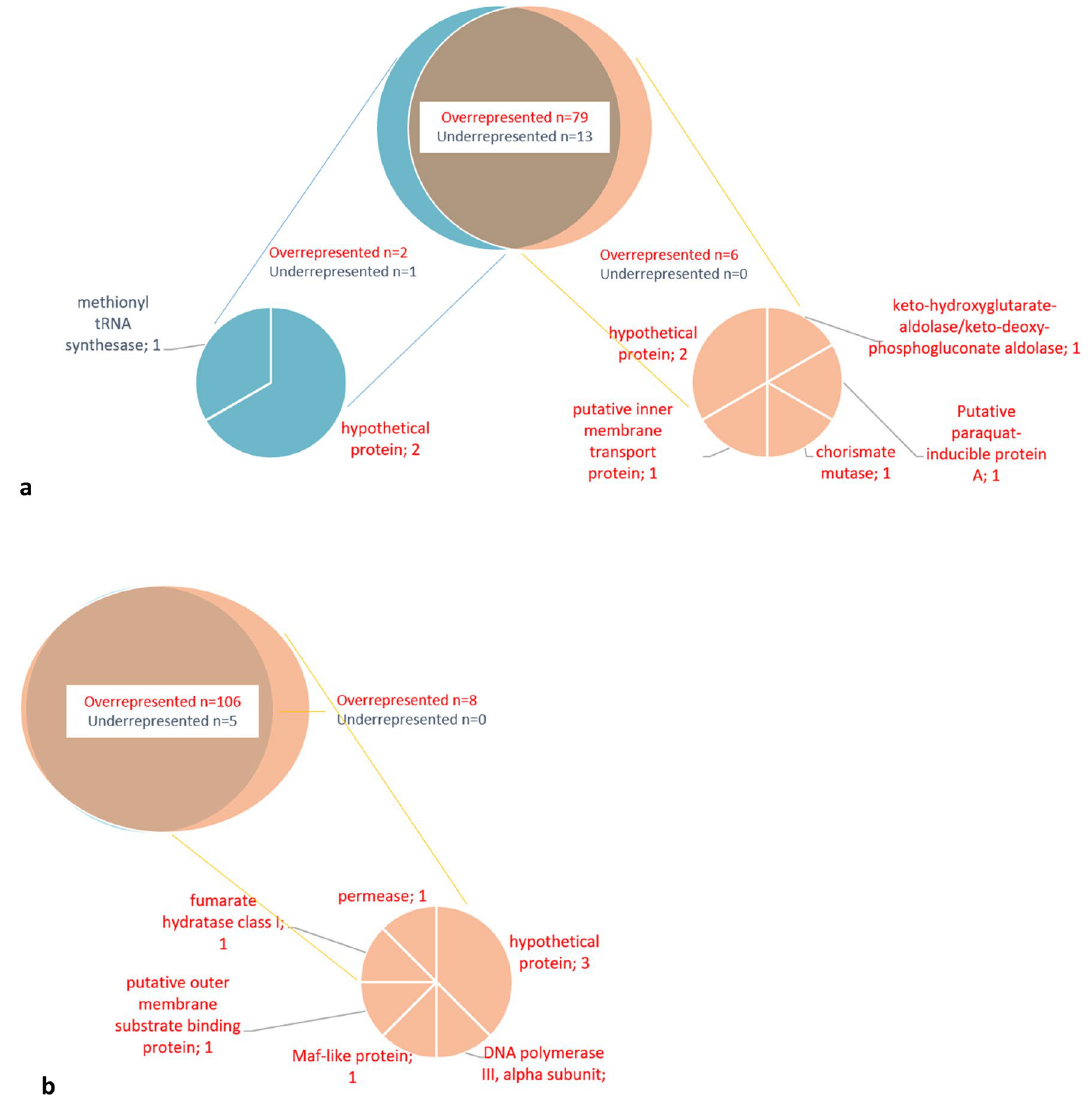
Figure 4. Venn diagram of the number of genes that had an overrepresentation (red font) and underrepresentation (blue font) of ( a) 5 ′ -ACACC-3 ′ motifs and ( b ) 5 ′ -CGA AT-3 ′ motifs in each N. meningitidis strain (2013 strain in blue circles and original UK strain in orange circles). Pie charts show the functions of the genes in which the under and overrepresented motifs were